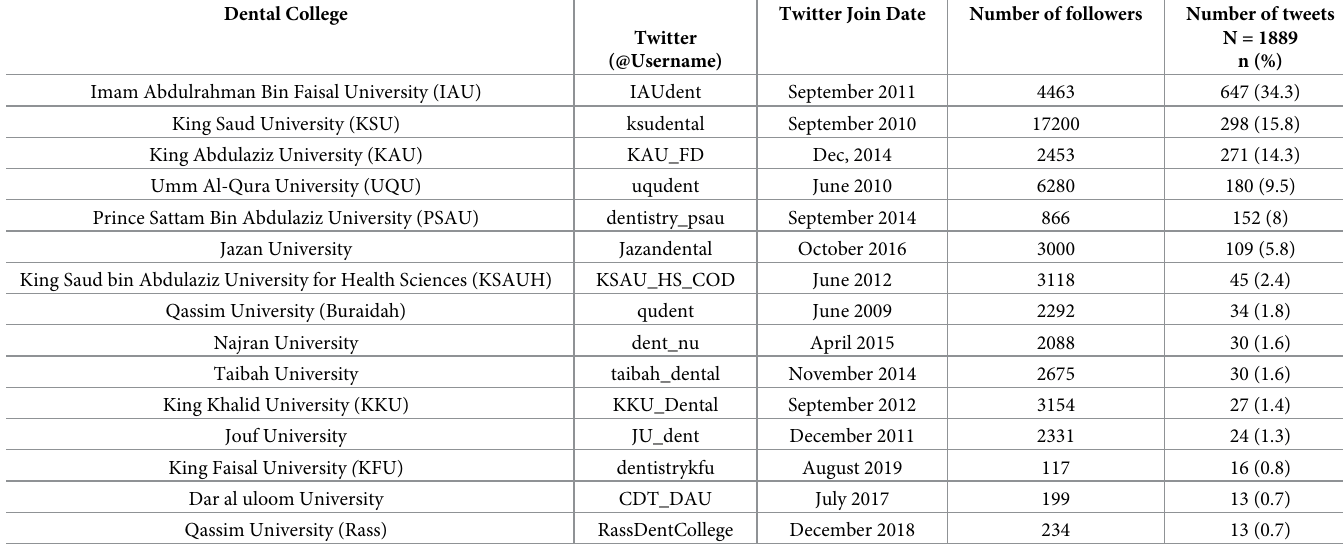
Table 2. Twitter accounts information and number of tweets per dental school (July 2019- July